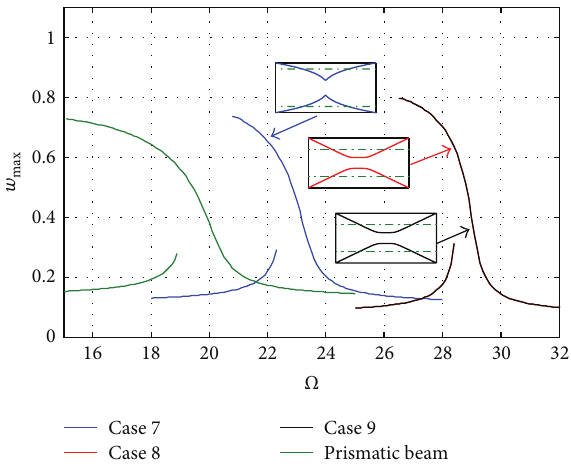
Figure 7: Frequency response curve of different optimized shape: Case 7–Case 9.